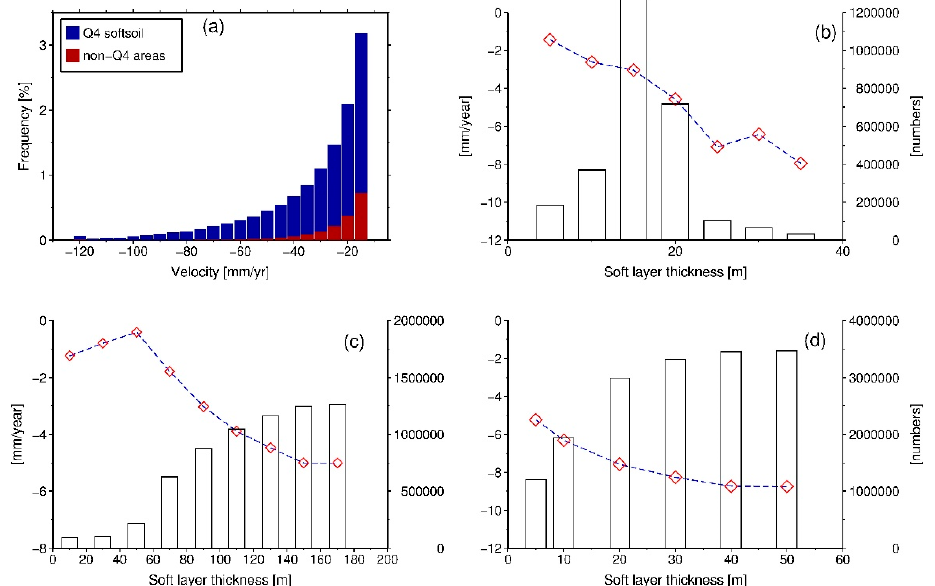
Figure 11. A quantitative relationship between subsidence and sedimentary thickness. ( a ) Deformation velocity histogram within (blue bars) and without (red bars) Holocene (Q4) deposits. ( b – d ) Histograms of sedimentary thicknesses in the LZP, CSP, and PRD. White bars represent the pixel numbers in the thickness bins, and red diamonds represent the average deformation velocity in the thickness bins.